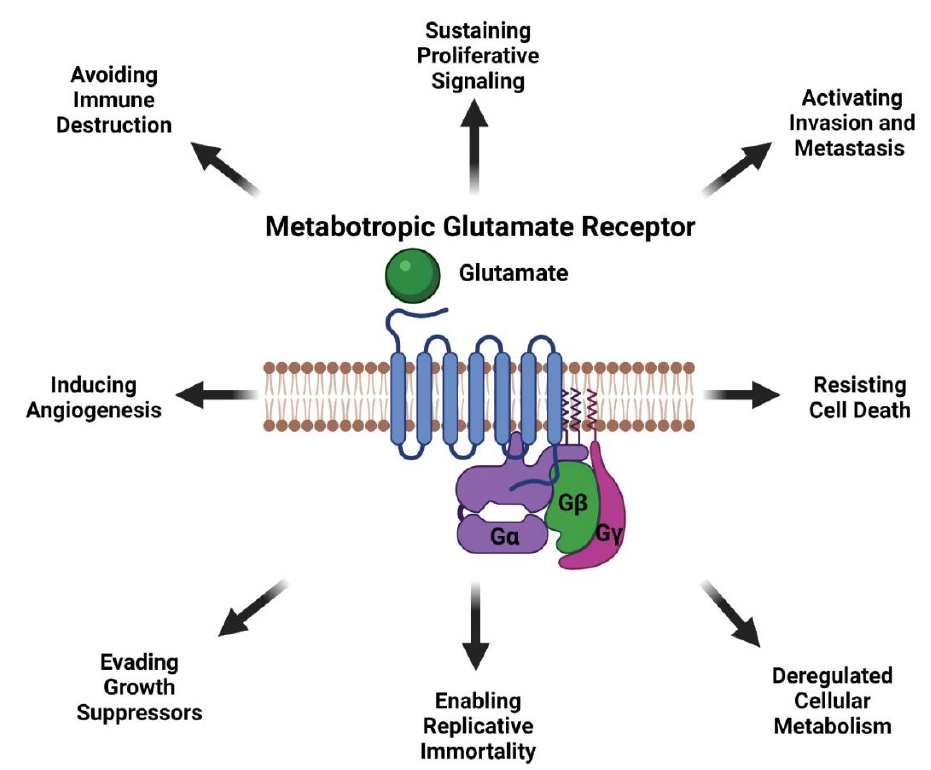
Figure 5. Oncogenic Activities of Metabotropic Glutamate Receptor in Melanoma. Created with BioRender.com (accessed on 1 July 2021).